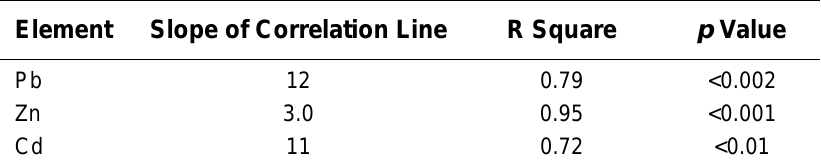
Correlations Between Emissions and Depositions of Pb, Zn, and Cd Calculated for Six 5-Year Periods Element Slope of Correlation Line R Square